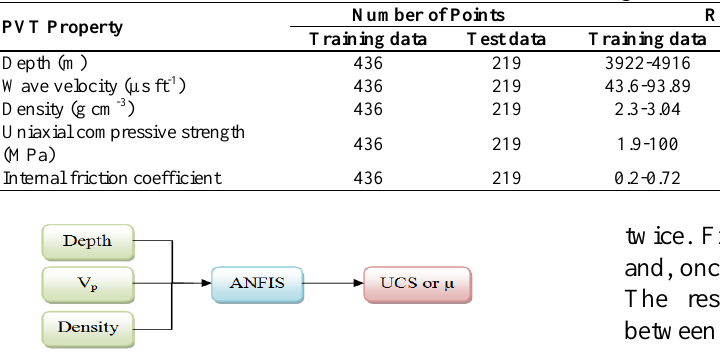
Figure 2. Schematic of output and input parameters of system (ANFIS).